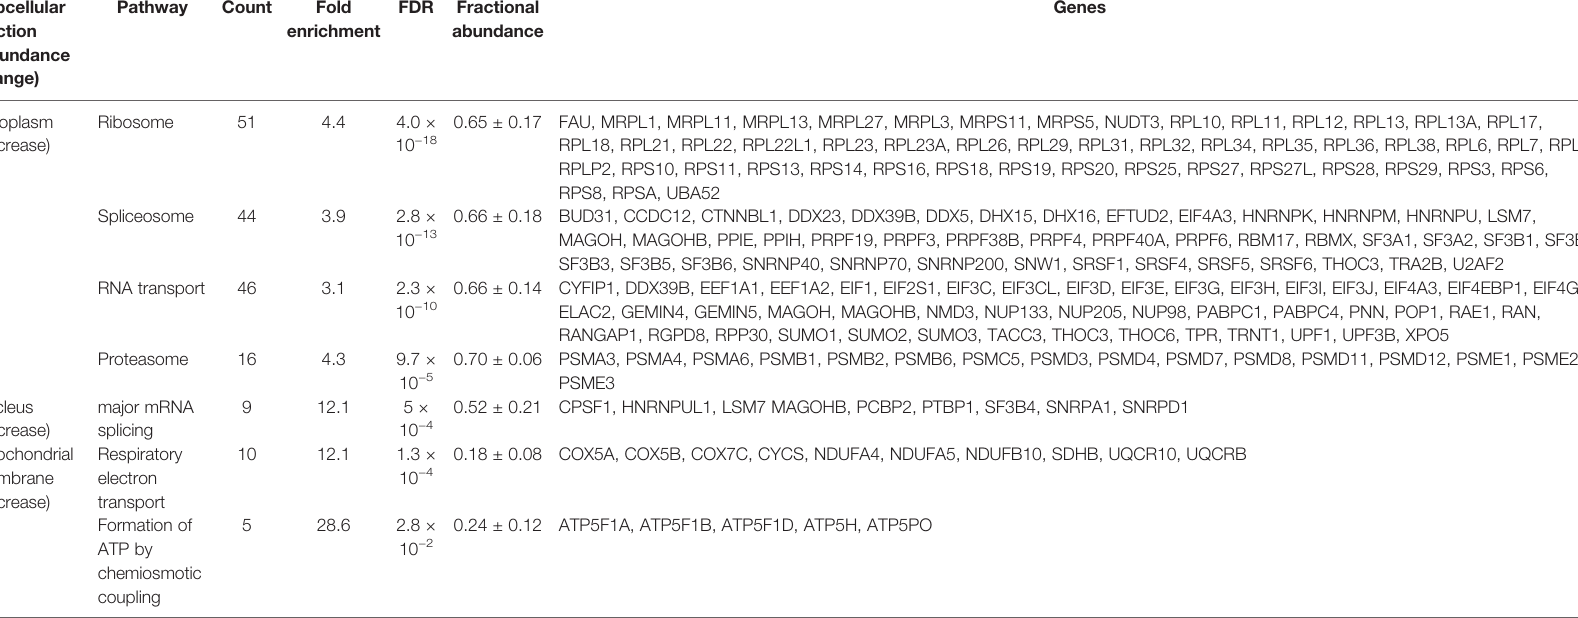
TABLE 3 | Pathway enrichment analysis of proteins changed in abundance in HEK293 cells by treatment with methylglyoxal.